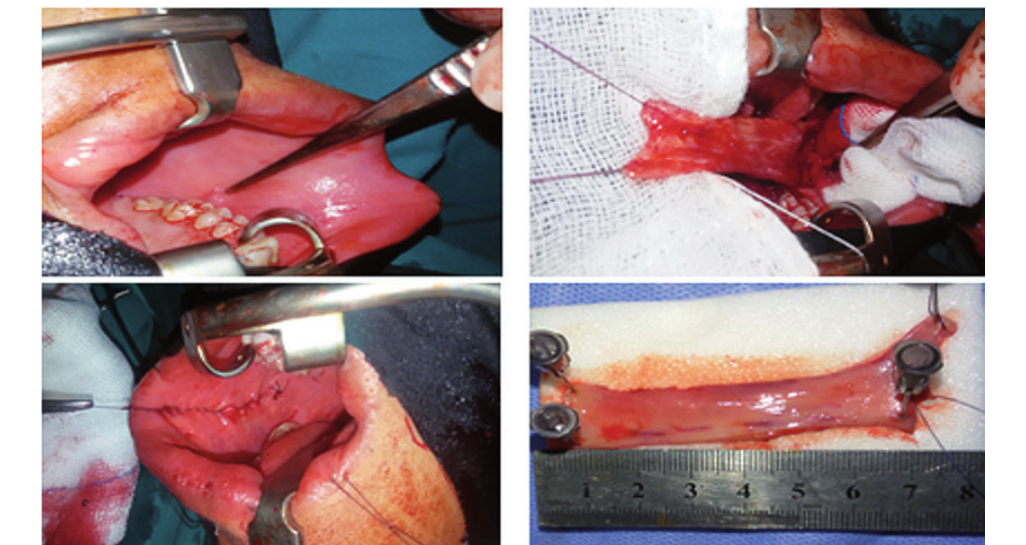
Figure 1 - harvesting of inner cheek buccal mucosa